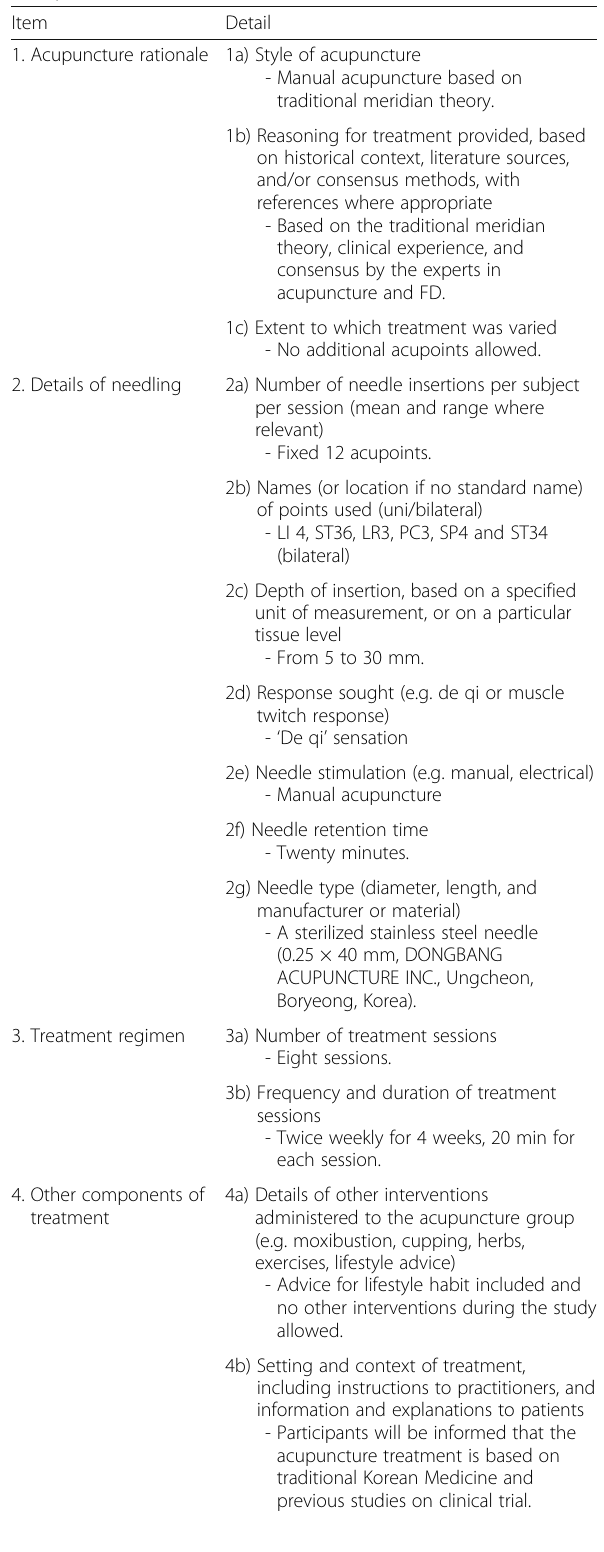
Table 2 Acupuncture treatment details based on the STRICTA (Macpherson H et al., [12]) checklist